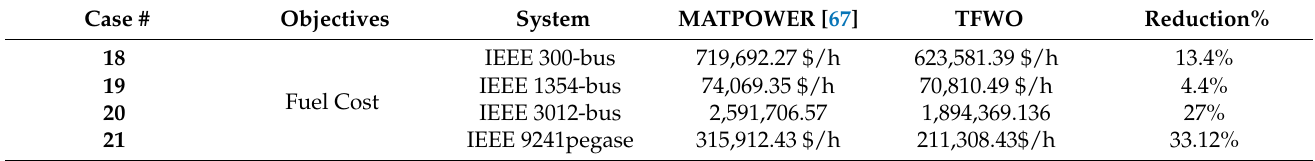
Table 11. TFWO versus recent optimization algorithms for the IEEE large scale test system: Cases 18–21.